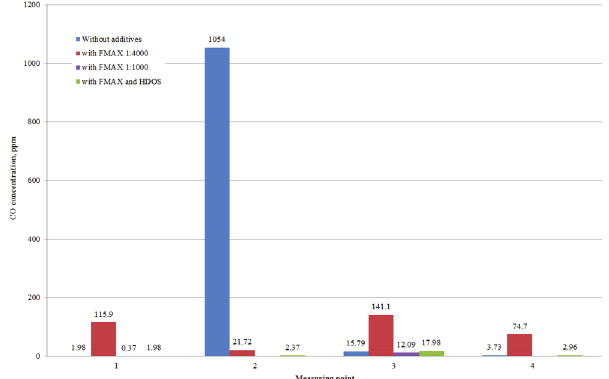
Fig. 5. Concentrations of CO measured in tests